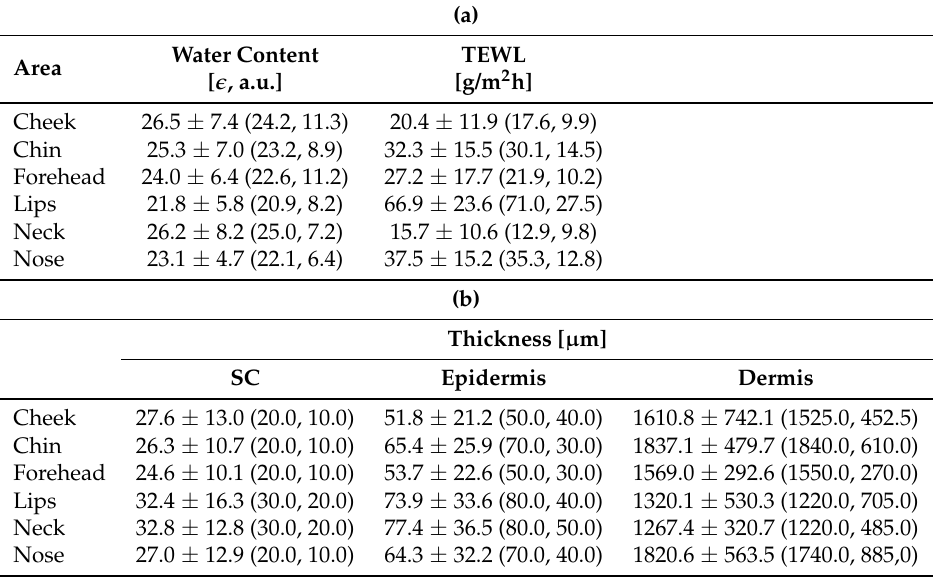
Figure 6. Results of the cluster analysis on the distribution of water content. From left to right, in descending order of water content: (1) cheeks, chin and neck; (2) chin, forehead, neck and nose; and (3) forehead, lips and nose. Table 1. Descriptive statistics of the water content, trans-epidermal water loss and skin thickness at the six facial sites. Data format is mean ± standard deviation (median, inter-quartile range).